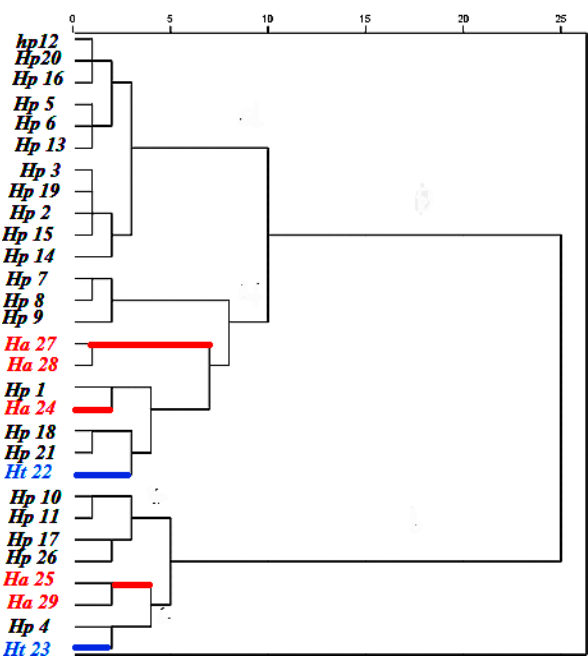
Figure 3. Phenogram by WARD method based on SDS-PAGE electrophoresis characters in Hypericum species. Note: Populations abbreviations are according to Table